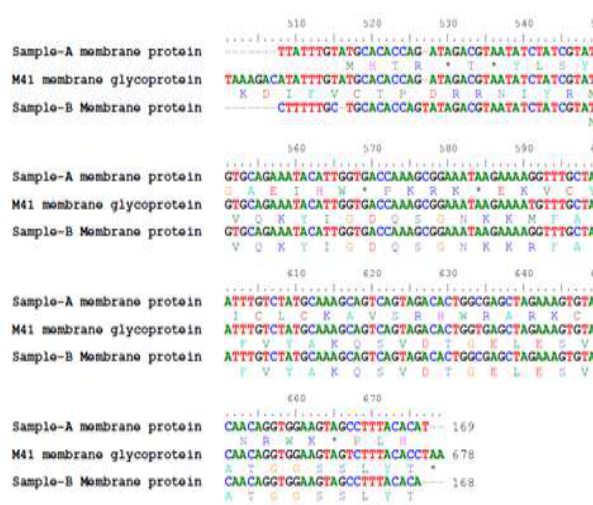
Figure-5. Multiple sequence alignment of both nucleotides and amino acids (in single letter code) for a total of 249 bp of 5b protein coding gene of isolates Ind/KA/07/1 (Sample A) and Ind/TN/07/2 (Sample B) along with that of M 41